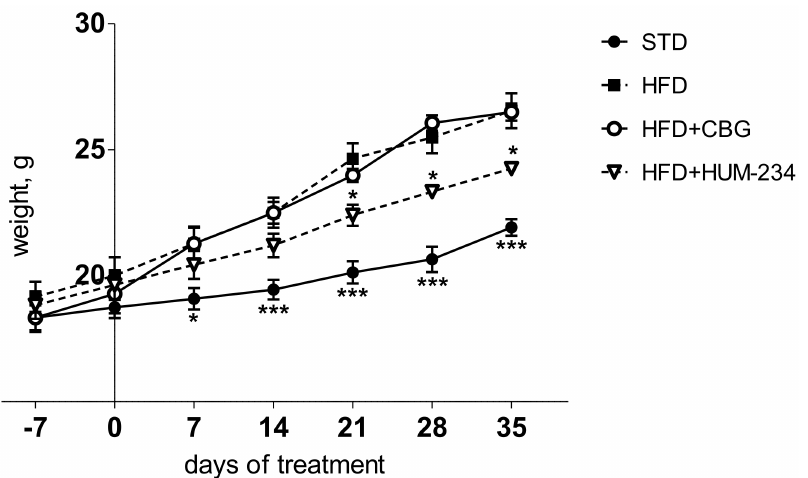
Figure 6. Anti-obesity evaluation of HUM-234 (25 mg/kg) in comparison to CBG (15 mg/kg), HFD (high fat diet) and STD (standard food diet). Statistical analysis by two-way ANOVA matching treatment groups in different days ( p -value < 0.0001). Post-hoc analysis by Bonferroni test. * p < 0.05, *** p < 0.001 comparing to HFD group.